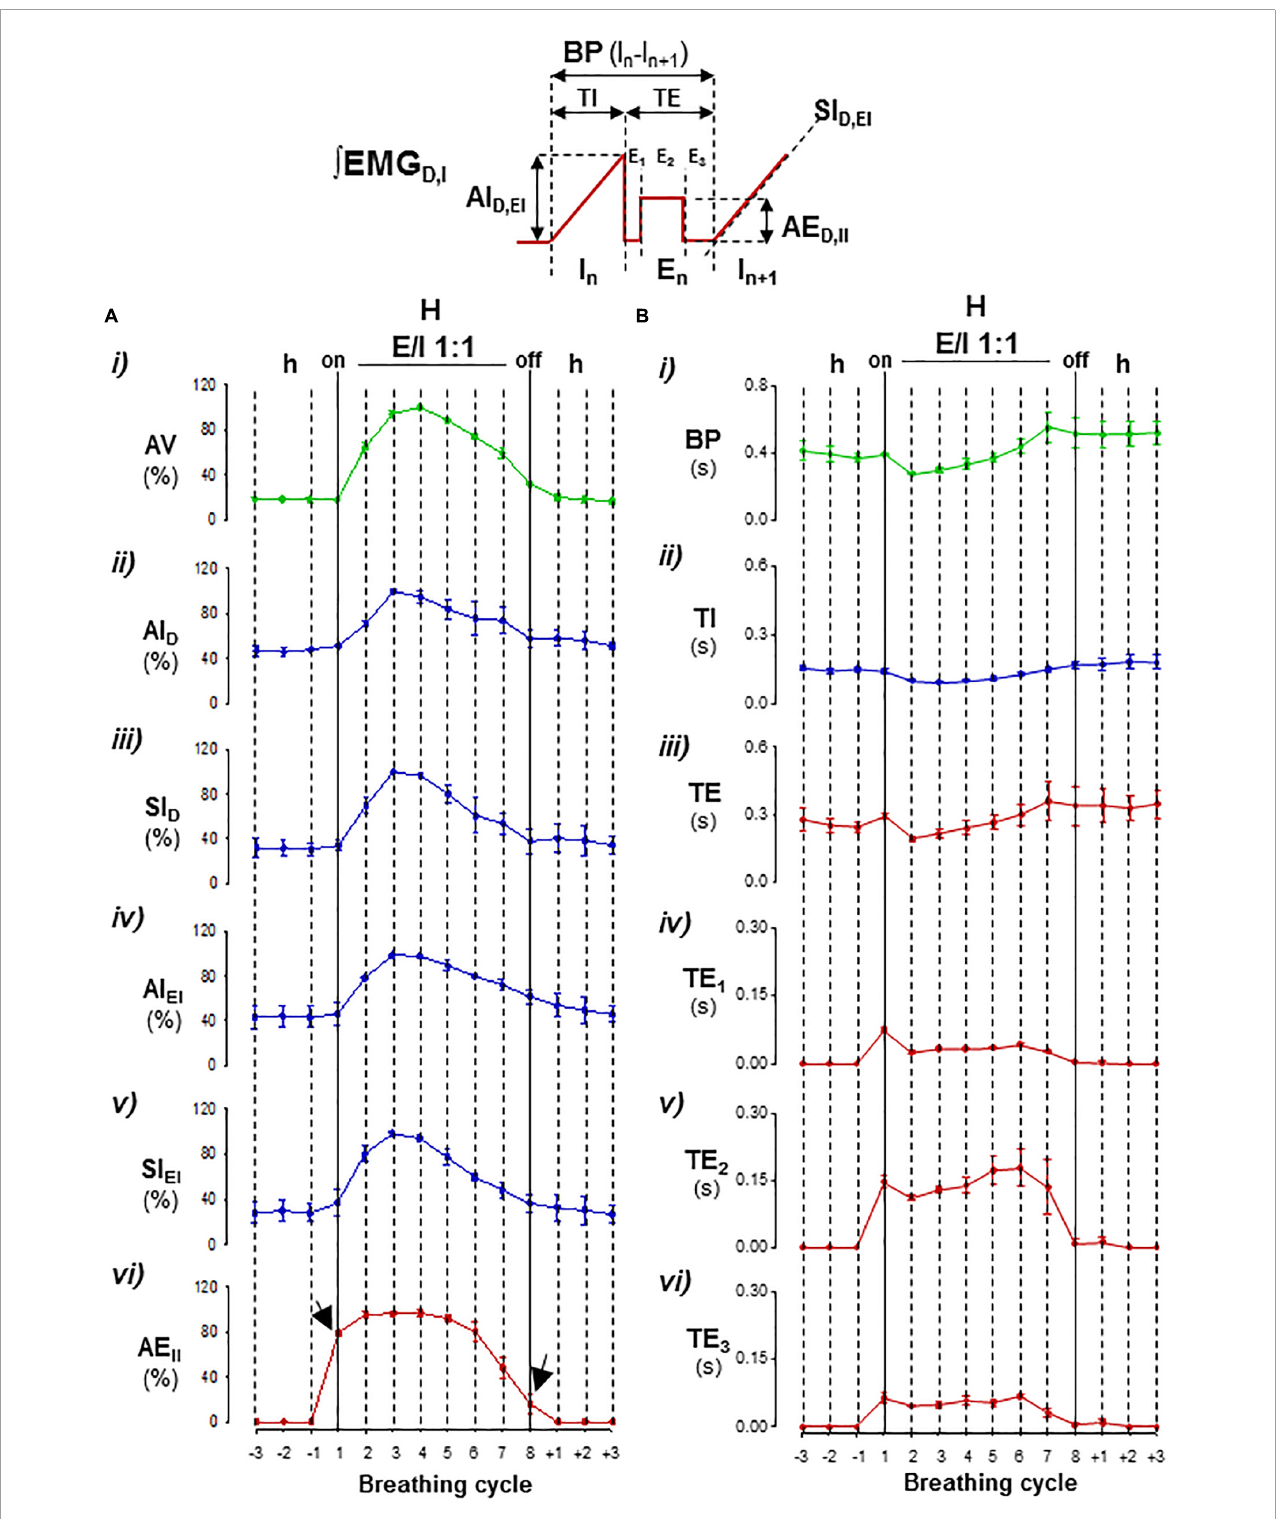
FIGURE3 Parameterization cycle-by-cycle of expiratory–inspiratory coupling. Inset, diagram of respiratory parameters: BP , period of breathing cycle; TI , time of inspiration; TE , time of expiration with a passive postinspiratory phase ( TE 1 ), an active phase ( TE 2 ), and a passive preinspiratory phase ( TE 3 ); IA and SI, peak-intensity and slope of the inspiratory ramp of the diaphragm ( D ) and external intercostal muscles ( EI ), and AE II , peak-intensity of expiratory internal intercostal muscle. Mean values ± SEM from 15 hyperpnea epochs of eight breathing cycles/mouse; N = 5. (A) Graphs of mean motor intensities and slopes normalized relative to the maximum in each mouse; (i) ventilatory motion amplitude, VA , (ii–v) inspiratory activity, IA D , SI D , IA EI , SI EI , and (vi) expiratory intensity, EA II , versus the breathing cycle. (B) Graphs of mean durations of BP (i), TI (ii), and TE, TE 1 , TE 2 , and TE 3 (iii–vi) versus the breathing cycle. Hypopnea–hyperpnea transitions and vice versa initiated and terminated by an active expiration (arrows); during expiratory–inspiratory coupling ( E/I 1:1 ), the magnitude of AV, IA D , SI D , IA EI , SI EI , and EA II values varied cycle-by-cycle in a crescendo–decrescendo manner (in A ), while, in minus extension, the durations of BP, TI, TE, TE 1 , TE 2 , and TE 3 first shortened and then lengthened (in B